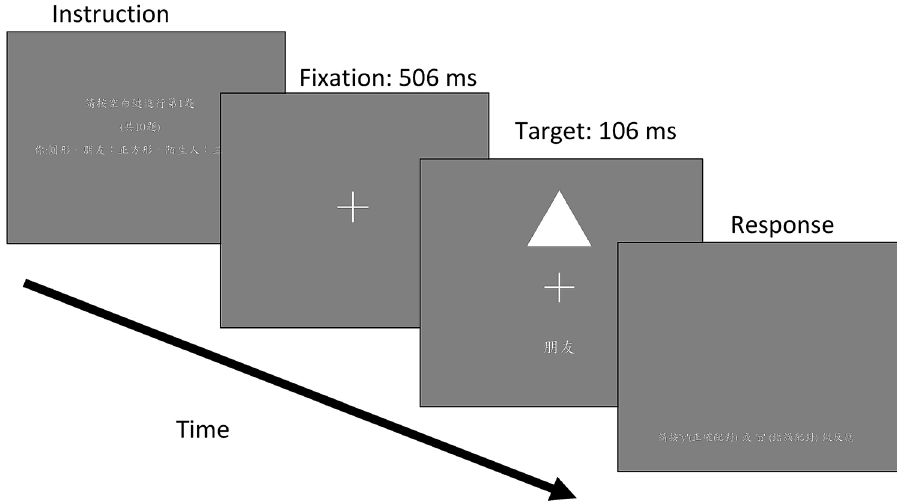
Figure 3. The stimulus sequence of the role–shape matching task. The text in the instruction display is translated as “ Please press space bar to proceed to Trial 1 ,” “(10 trials in total),” and “ You: Disc; Friend: Square; Stranger: Triangle.” The word shown in this example target display is “friend.” In the response display, the message can be translated as “please press ‘y’ (correct) or ‘n’ (incorrect) to respond.” In the actual experiment, there were 288 trials in total, and the response display was followed by a feedback display where “correct” or “incorrect” was printed at the center of the display. The “incorrect” feedback display was accompanied with a